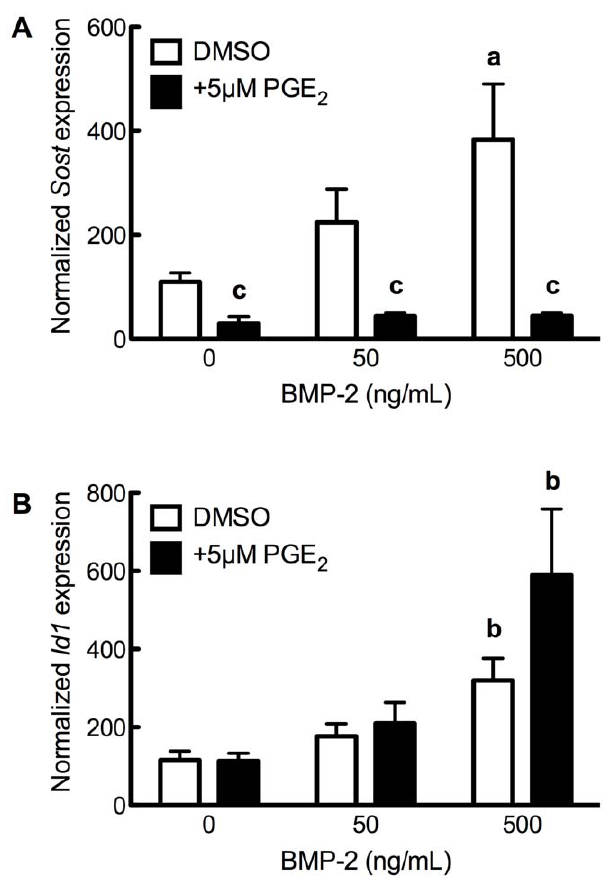
Figure 7. PGE 2 decreases Sost without affecting BMP signaling. ( A ) Cells were treated with BMP-2 (0–500 ng/mL) in the presence or absence of 5 m M PGE 2 for 3 hours, after which ( A ) Sost or ( B ) Id1 expression was monitored. Compared to vehicle control, a indicates p , 0.05 and b indicates p , 0.01; compared to BMP-2 without PGE 2 ; , c indicates p , 0.001.